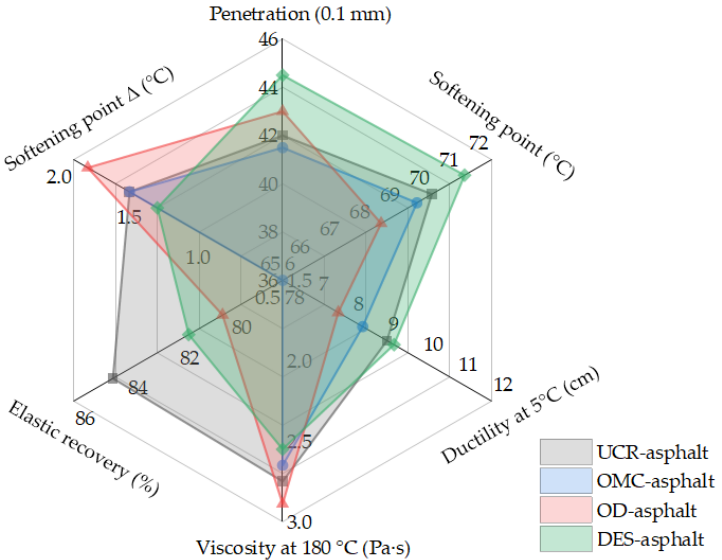
Figure 12. Radar chart for the chemical adjuvants based on the physical properties of the asphalt binder containing the activated crumb rubber powder prepared by the chemical treatment